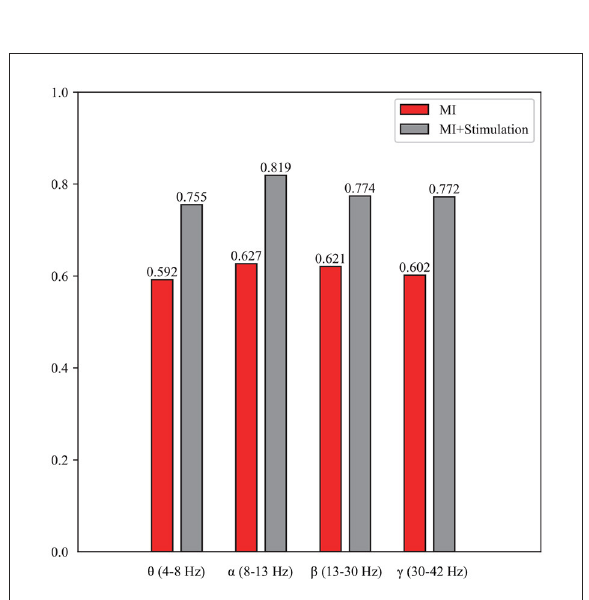
FIGURE7 The classification performance of the lower limb movement imagery with and without stimulation for θ , α , β , and γ